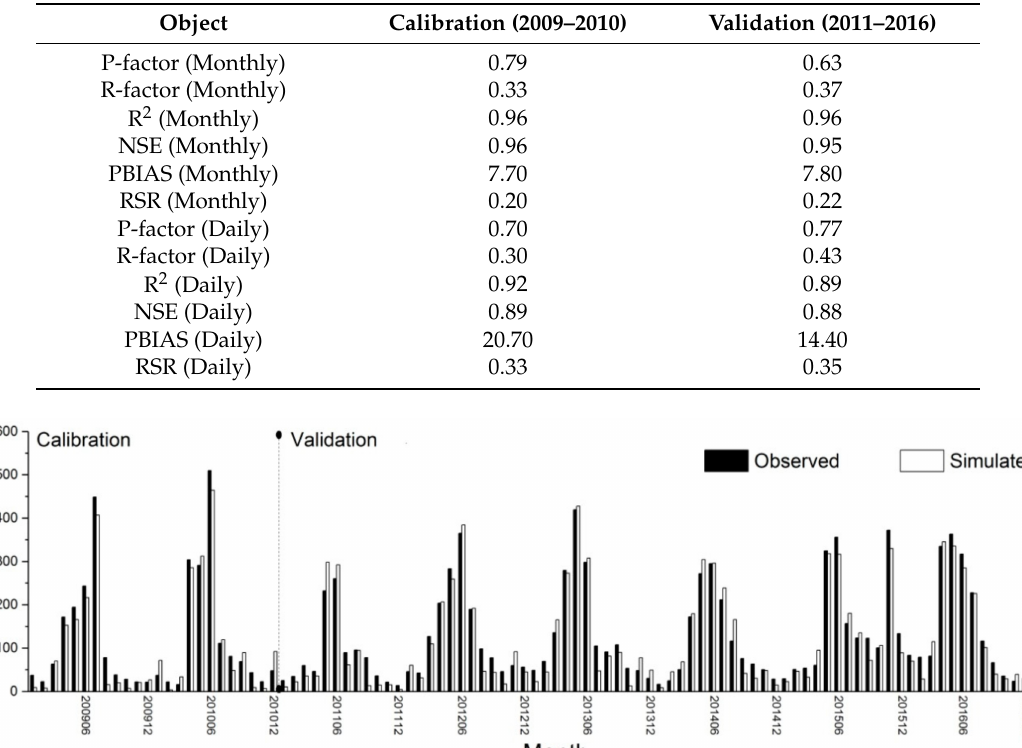
Table 4. Performance statistics for the flow simulations.